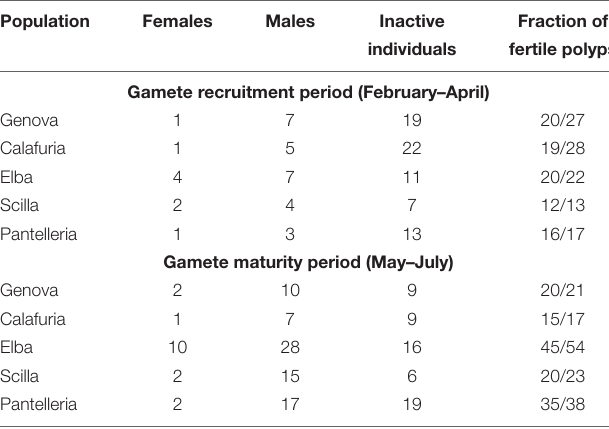
TABLE 2 | Number of females, males, inactive individuals and fraction of fertile polyps in each population for gamete recruitment and gamete maturity